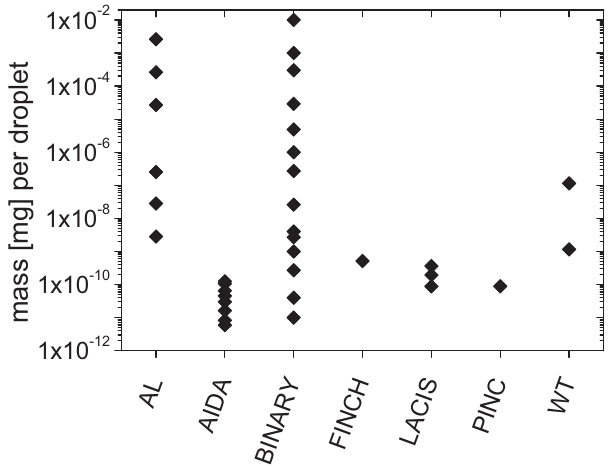
Figure 1. Snomax mass per droplet examined by the different in- struments. For AL, BINARY, and WT values follow directly from the Snomax concentration in the suspensions used to produce the droplets, and from the respective droplet size. For AIDA, FINCH, LACIS, and PINC masses were derived using Eq.